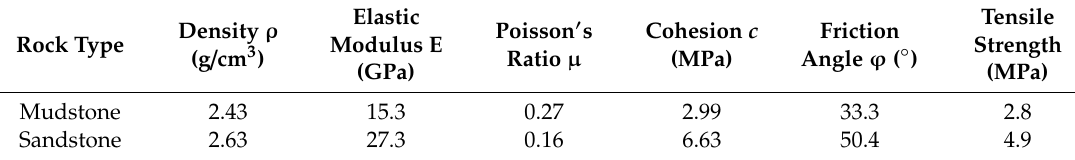
Table 1. Material parameters of the bedrock.